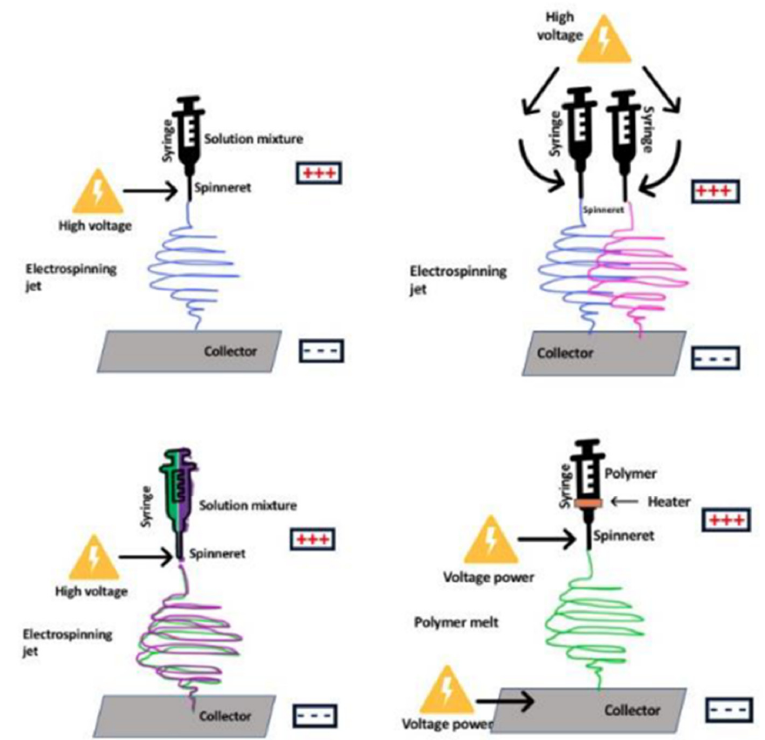
Figure 5. Fabrication processes for electrospun nanofiber composites [201].